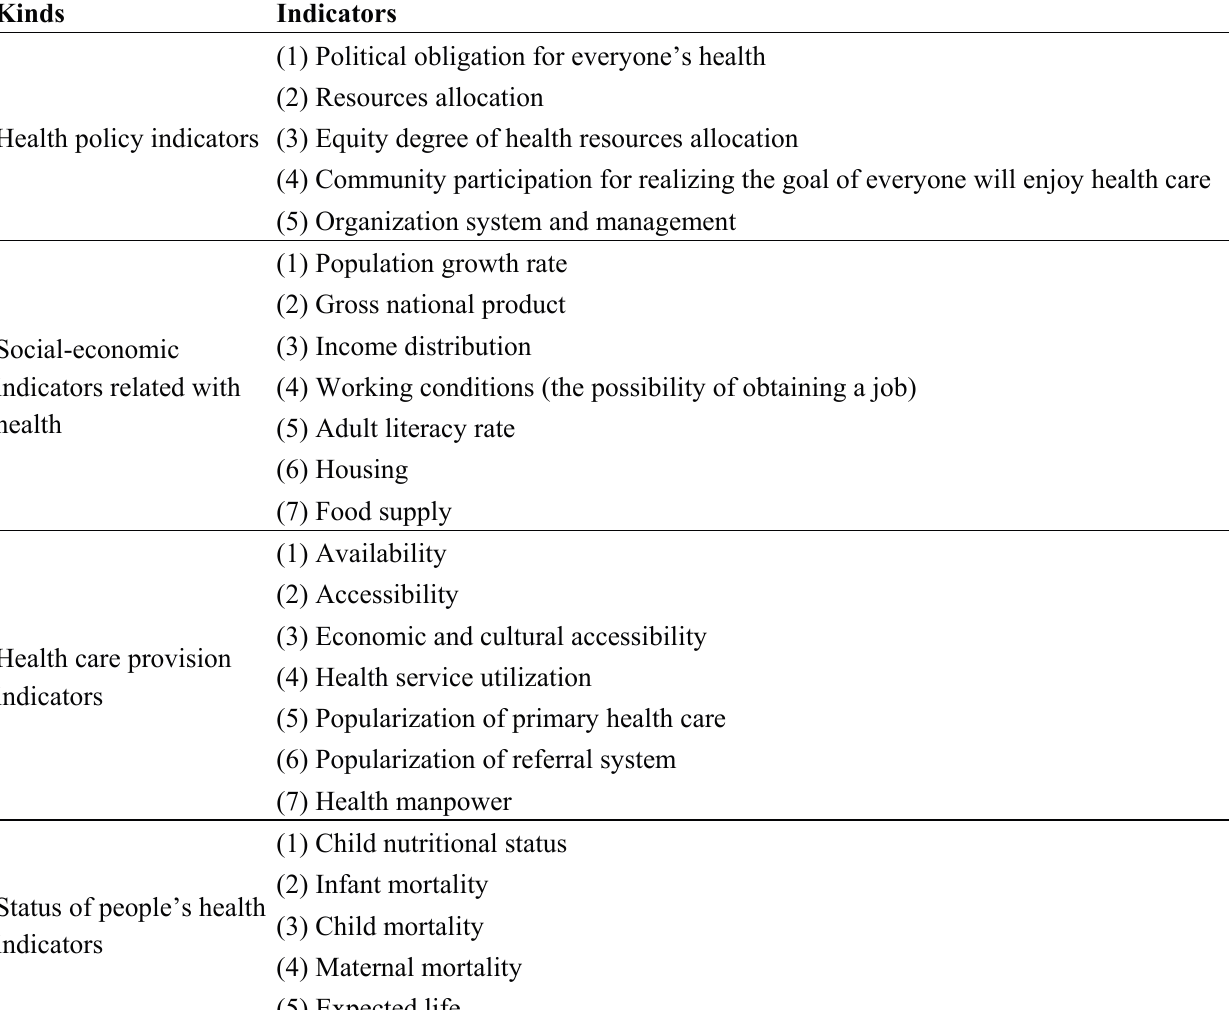
Table 1. The evaluation indicators of PHC formulated by